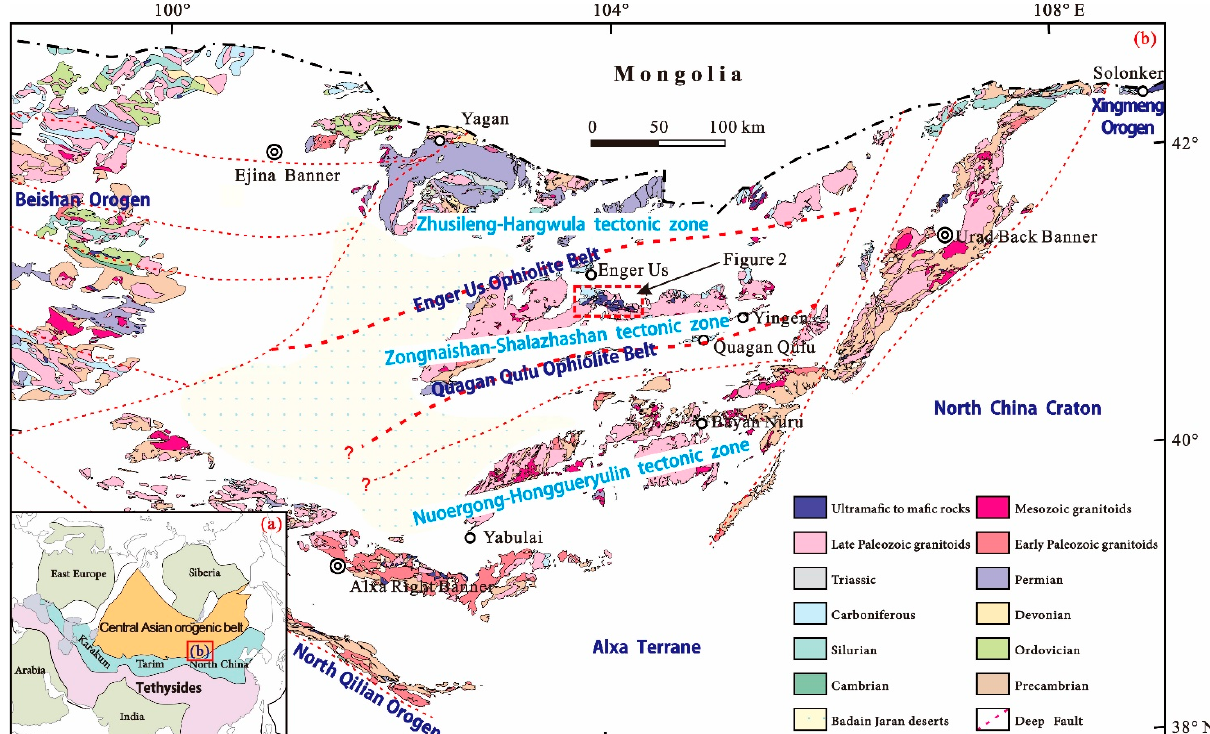
Figure 1. ( a ) Simplified tectonic sketch map of the Central Asian orogenic belt (CAOB) with the location of the studied area. Modified after [24]; ( b ) Geological map of the northern Alxa. Modified after [20].